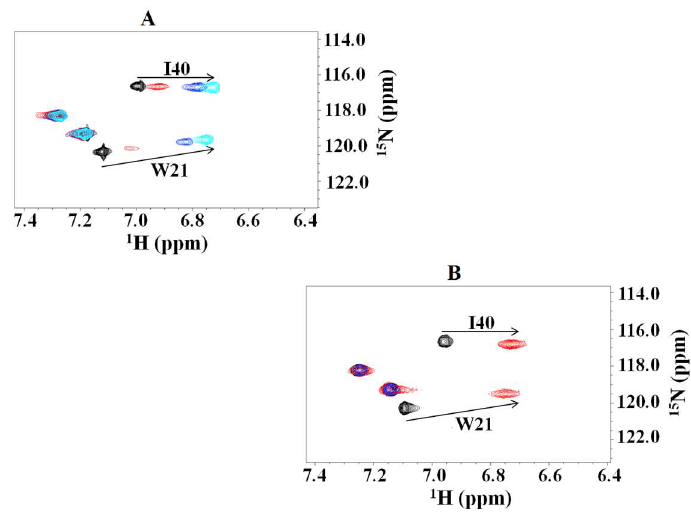
Figure 2. 15 N HSQC NMR of W21 and I40 in labeled CUBAN, upon stepwise addition of: NEDD8 ( A ); and ubiquitin ( B ). The molar ratios here utilized are 15:1, 8:1 and 1:1.